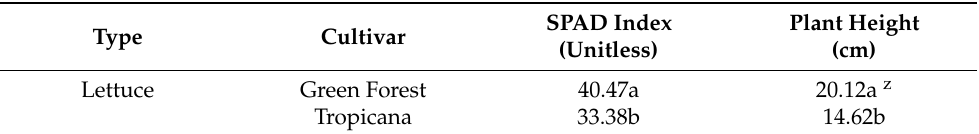
Table 7. The least square means of cultivars (‘Green Forest’ and ‘Tropicana’) on the growth of lettuce grown in the ebb and flow hydroponic systems at OSU research greenhouses in Stillwater, OK, for experiment